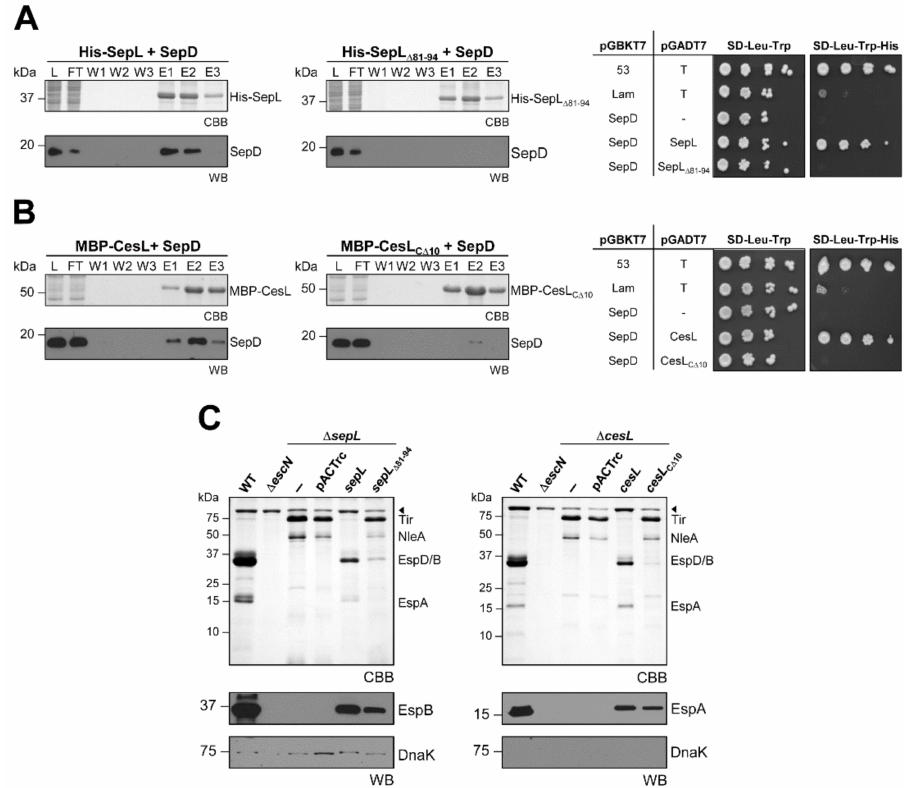
Figure 3. CesL and SepL interaction with SepD is required to regulate secretion hierarchy. ( A ) His- SepL or His-SepL ∆ 81-94 and ( B ) MBP-CesL or MBP-CesL C ∆ 10 recombinant proteins were immobilized on Ni-NTA or amylose resin, respectively, and then a cleared lysate (L) containing untagged SepD was loaded onto the protein-coupled resin. Samples from the flow-through (FT), washes (W) and elutions (E) were collected and analyzed by CBB-stained SDS-PAGE and immunoblotting using anti-SepD antibodies (left panels). S. cerevisiae PJ69-4a/ α strain carrying plasmids pGADT7 and pGBKT7 or their indicated derivatives was serially diluted and spotted onto SD-Leu-Trp medium as a growth control, and onto SD-Leu-Trp-His medium to test for protein interactions. The plasmid pairs pGADT7-T/pGBKT7-53 and pGADT7-T/pGBKT7-Lam were used as positive and negative controls, respectively. The plasmid pair pGBKT7-SepD/pGADT7-T was used as a SepD self-activation control (right panels). (C) Secreted proteins from EPEC wild-type strain (WT), ∆ escN strain , and ∆ sepL (-) or ∆ cesL (-) strains harboring an empty vector (pACTrc), plasmid pMATpL expressing SepL, plasmid pMATpL ∆ 81-94 expressing SepL ∆ 81-94 , plasmid pMATcL expressing CesL or plasmid pMATcL C ∆ 10 expressing CesL C ∆ 10 , were resolved on CBB-stained SDS-PAGE. Immunoblotting of EspB, EspA and DnaK proteins is shown